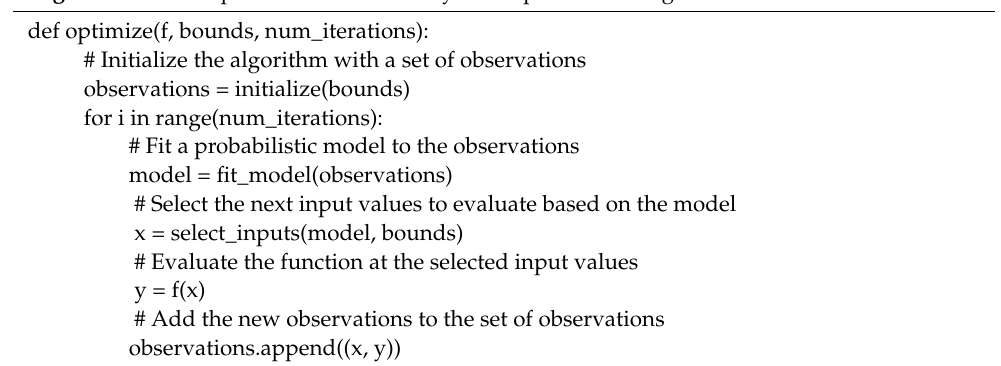
Algorithm 1: Basic pseudocode for the Bayesian optimization